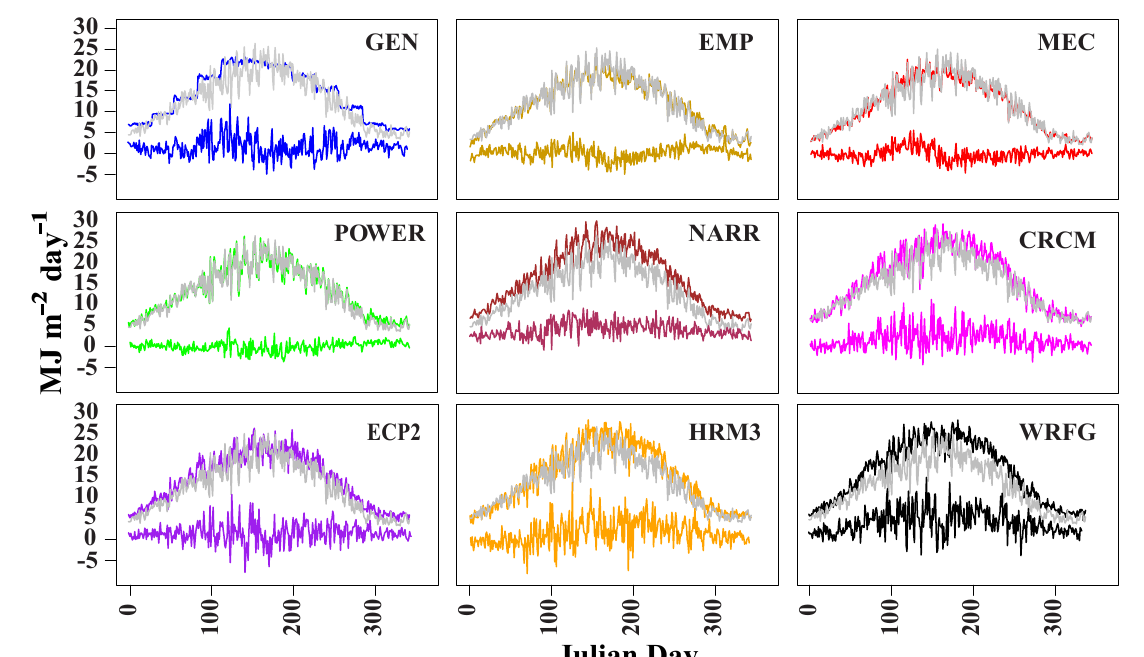
Figure 2. Mean daily estimated (color) and observed (grey) solar radiation (upper lines) and mean biases (lower line) of estimated solar radiation at Hancock, Wisconsin for the eight-year study period. Abbreviations refer to the sources of estimated daily radiation, i.e., weather generator (GEN), empirical (EMP) and mechanistic (MEC) models, Prediction of Worldwide Energy Resource (POWER), North American Regional Reanalysis (NARR), and the North American Regional Climate Change Assessment Program (NARCCAP) regional climate models (Canadian Regional Climate Model (CRCM), Experimental Climate Prediction Center/Regional Spectral Model (ECP2), Hadley Regional Model 3 (HRM3), and Weather Research and Forecasting model (WRFG)).